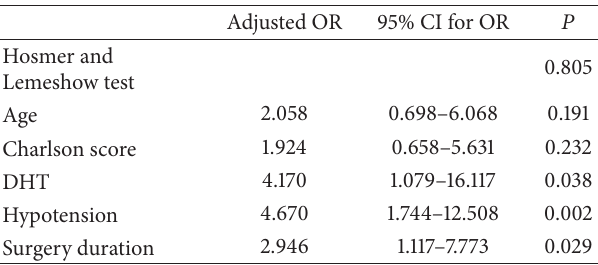
Table 4: Multivariate logistic regression with “complications” as dependent variable.